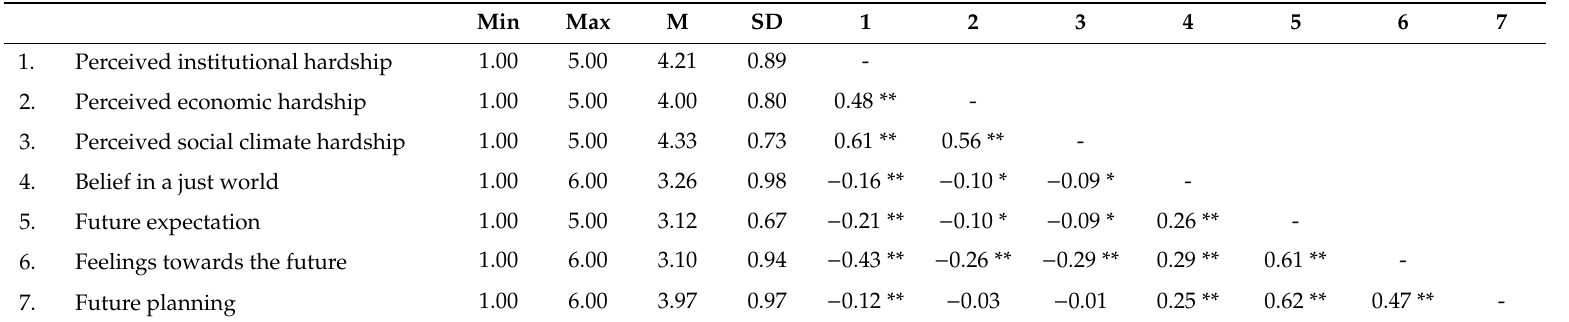
Table 1. Descriptive statistics and bivariate